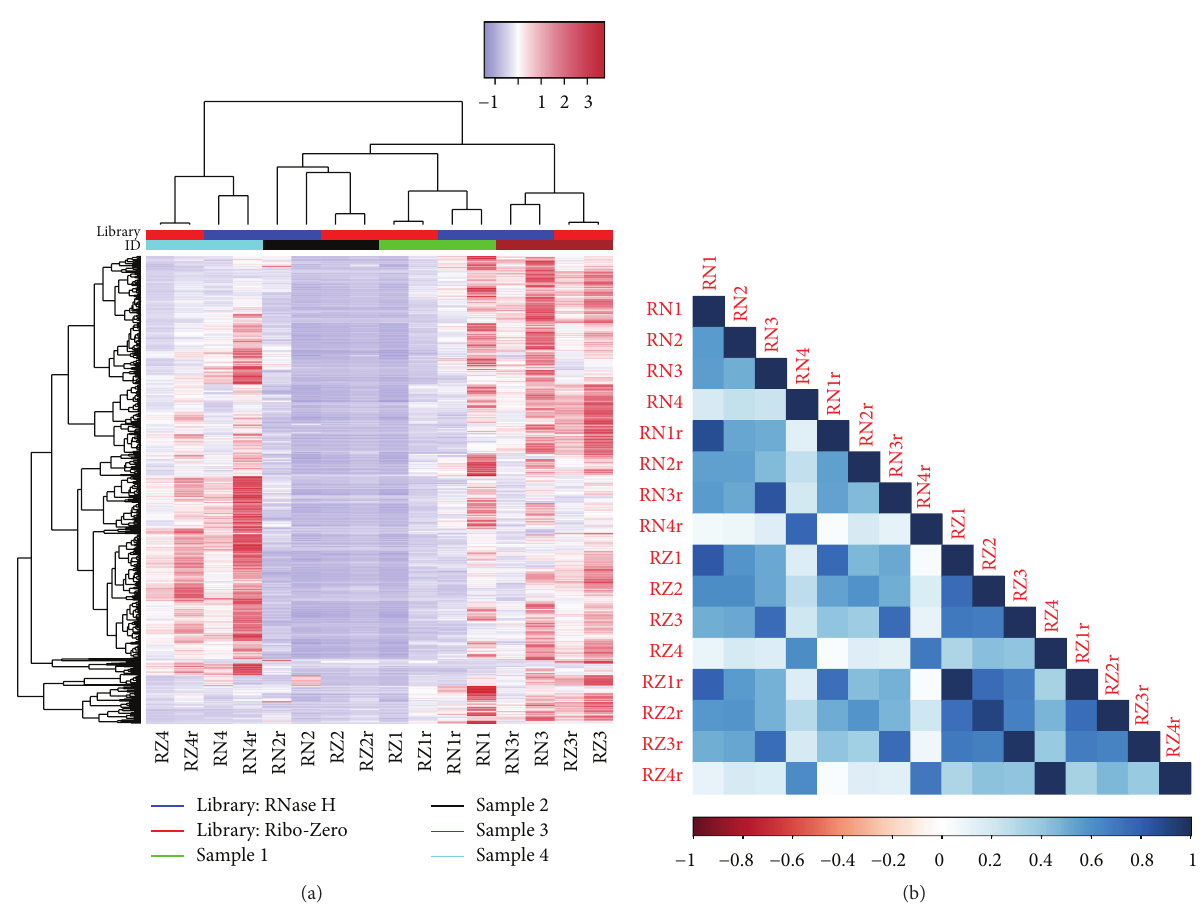
Figure 1: (a) Unsupervised cluster using all detected RNAs. Samples were clustered first by replicates then by rRNA depletion method. (b) Pairwise Spearman correlation heatmap between all samples. Ribo-Zero produced higher correlation between repeats than RNase H. The samples RN4 and RN4r produce low correlations with other samples compared to other random pairs. This could be the result of variation in the sample or variation introduced by the RNase H